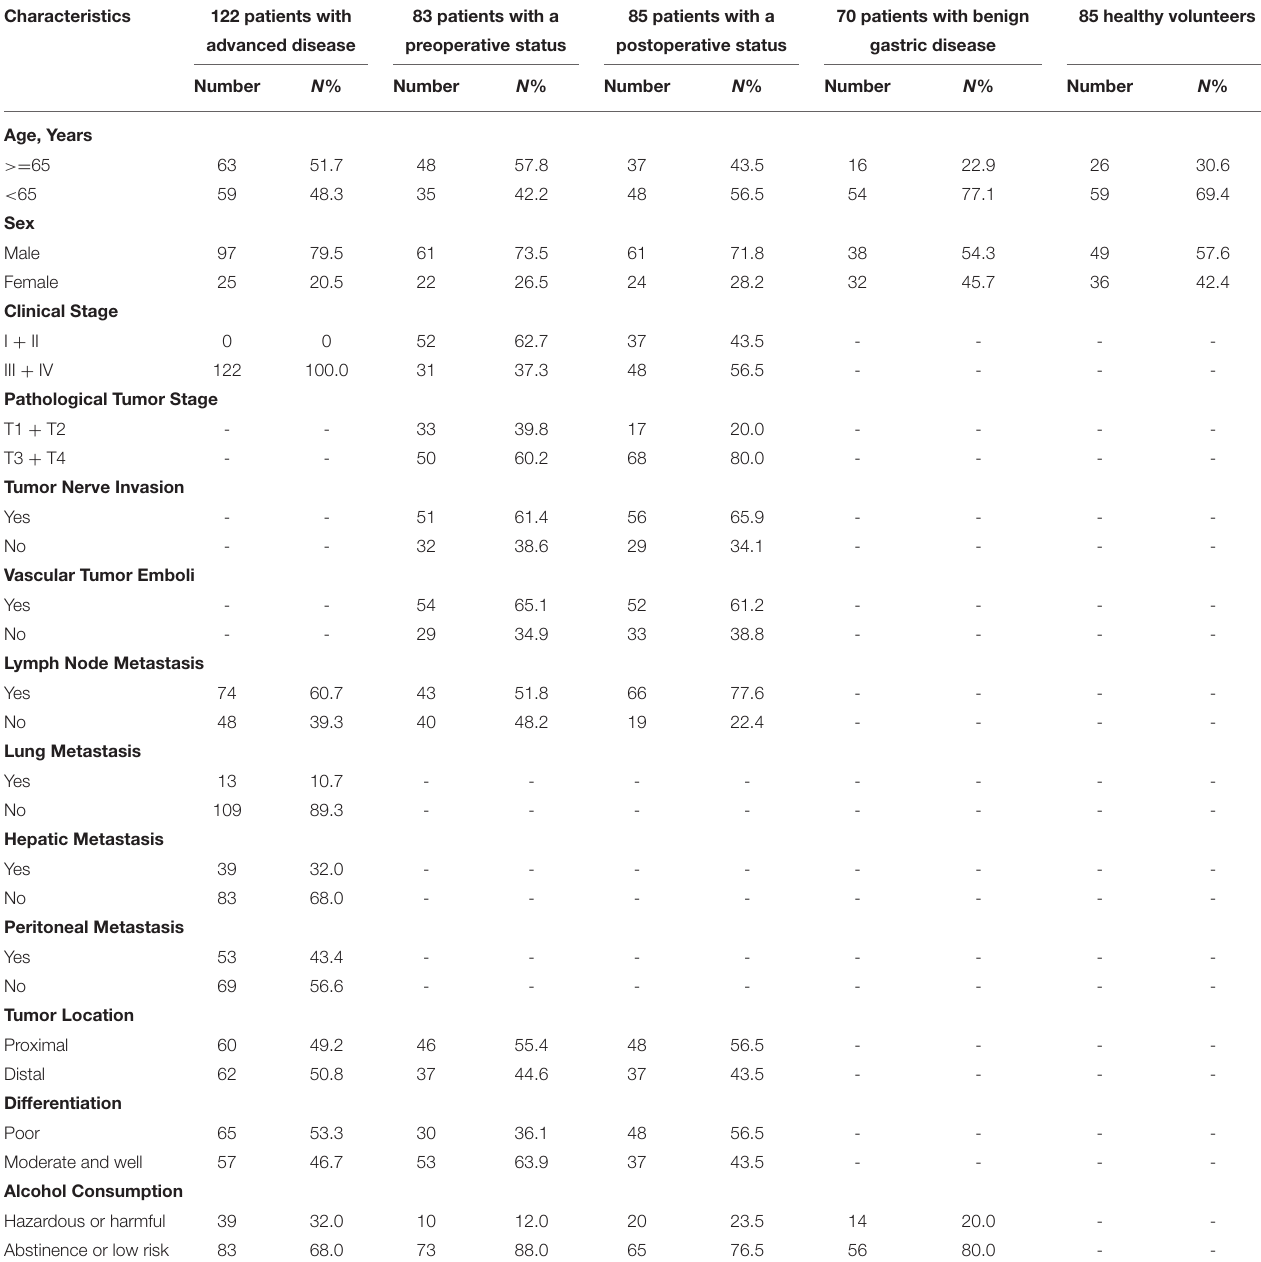
TABLE 1 | Clinicopathological characteristics of GC patients and controls. Characteristics 83 patients with a 85 patients with a 70 patients with